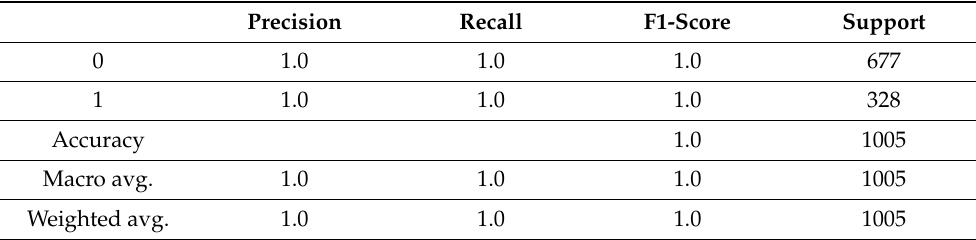
Table 9. Decision tree classification report.